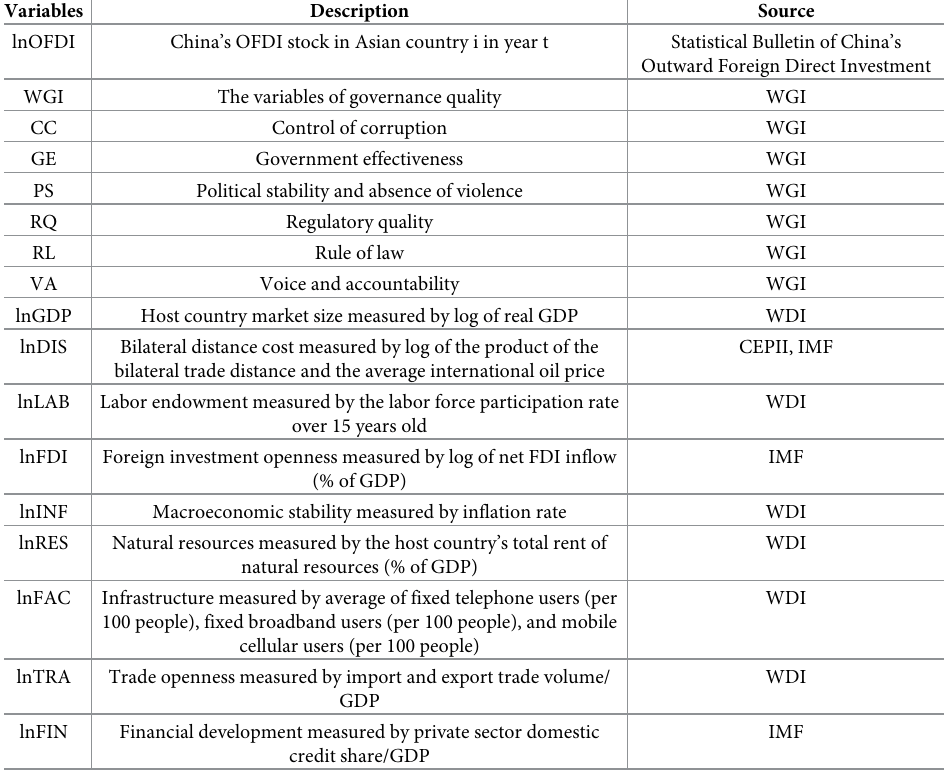
Table 1. Data description and